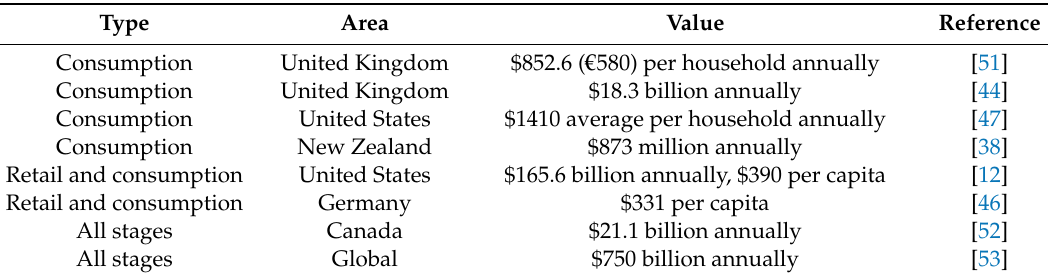
Table 4. Summary the economic cost of